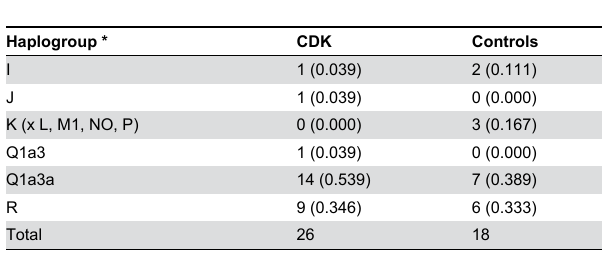
Table 2. Y-chromosome haplogroup frequencies of Mapuche CDK patients and